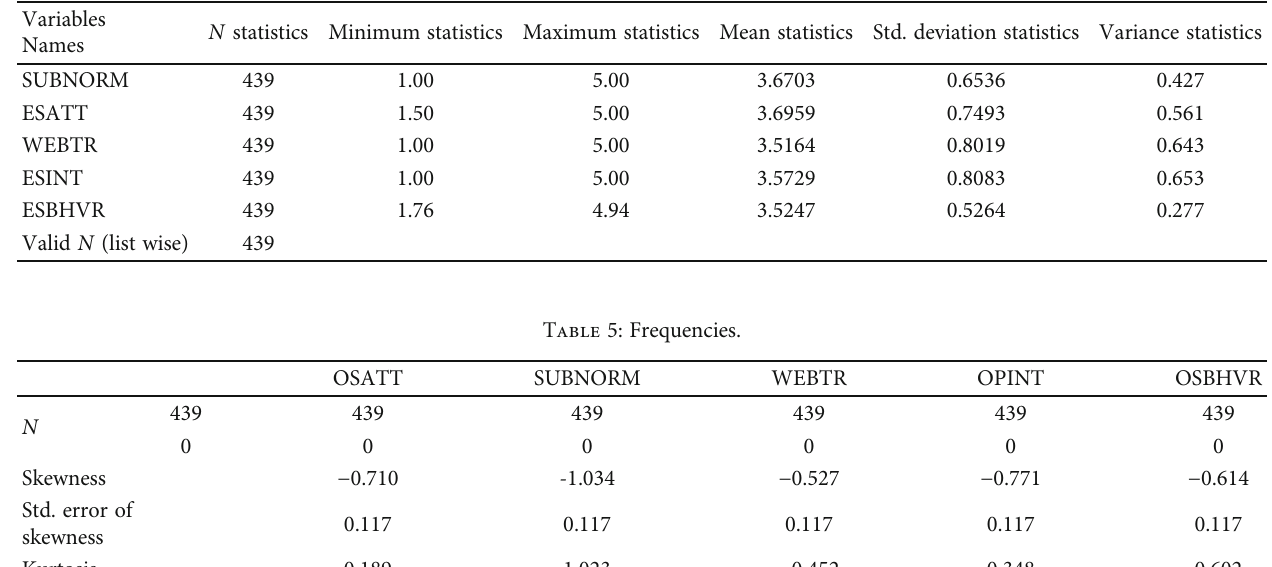
Table 4: Descriptive statistics of the study.